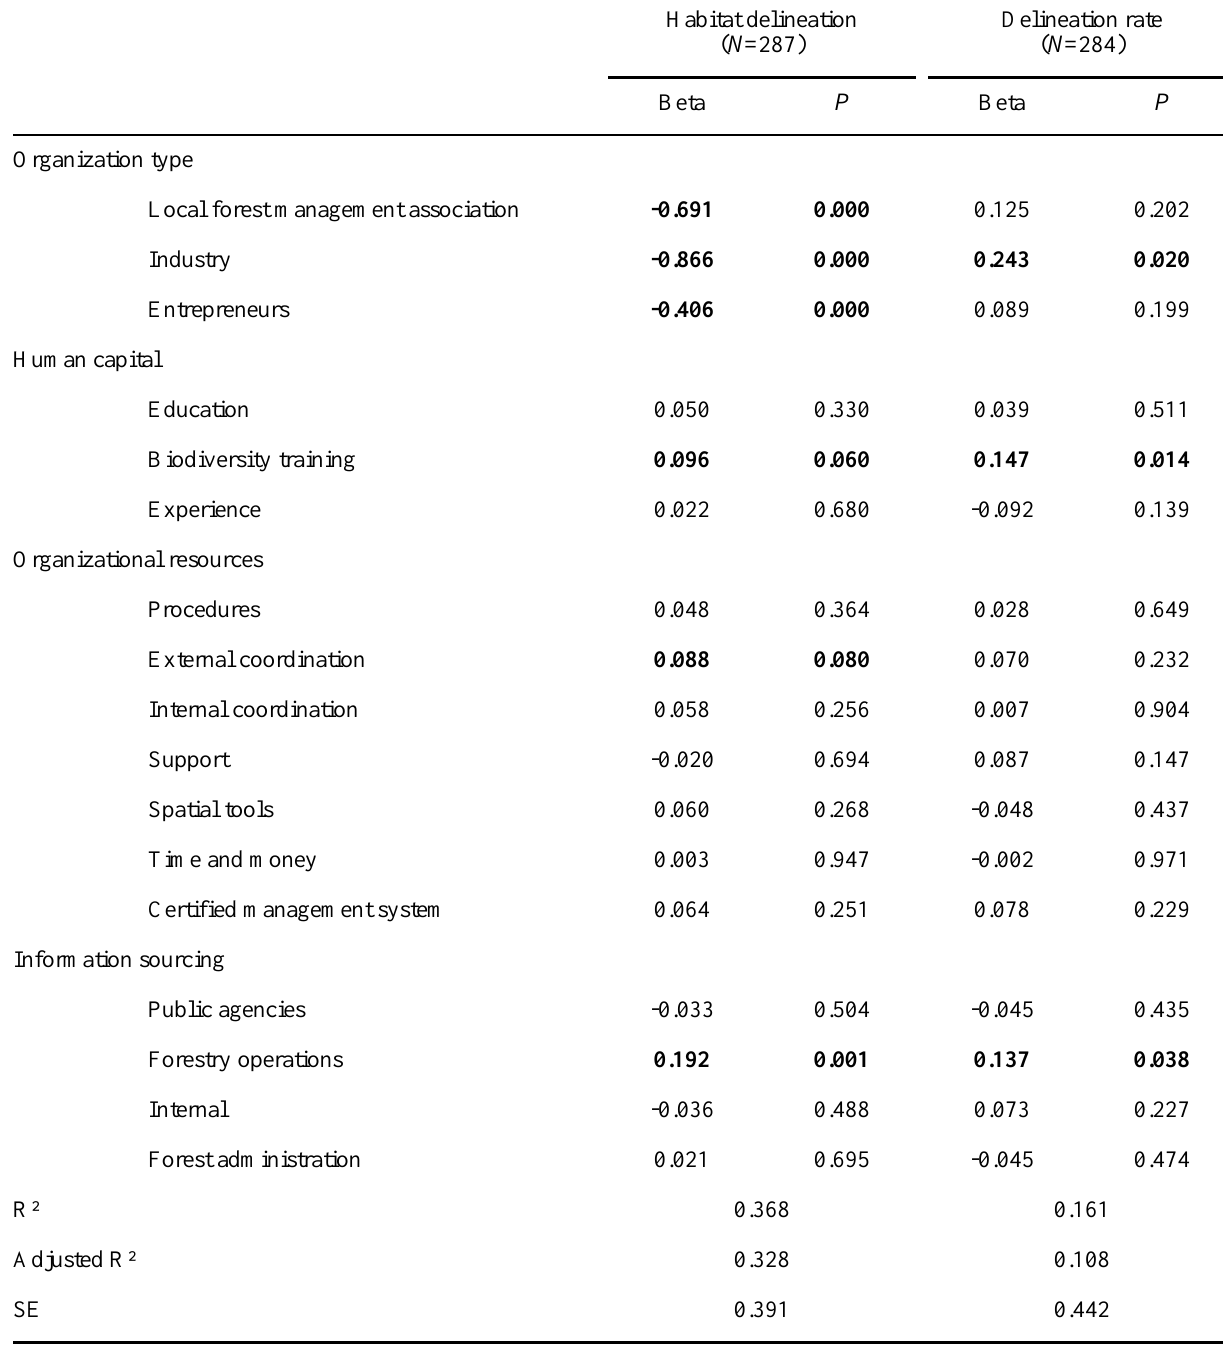
Table 4 . Regression analyses of organization types and competencies on delineation and delineation rate (both log transformed): standardized beta and significance. Bold values are significant at P > 10